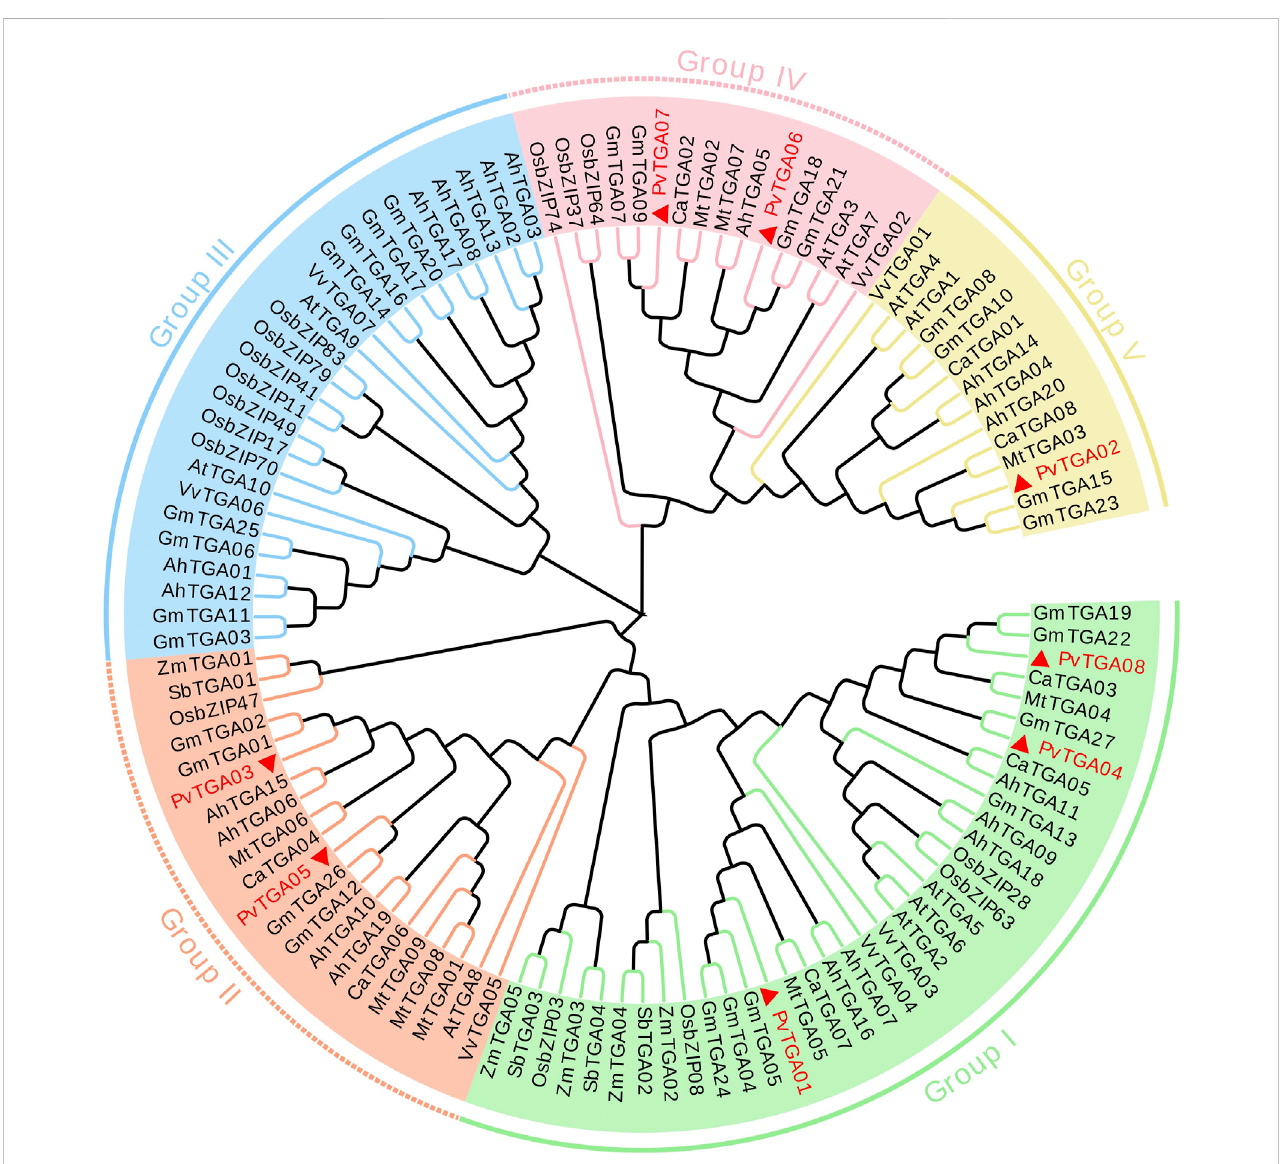
FIGURE 3 Evolutionary relationship analysis of TGA proteins from common bean ( Phaseolus vulgaris ; Pv). TGA amino acid sequences from the Phaseolus vulgaris , Arabidopsis (At), Arachis hypogaea (Ah), Glycine max (Gm), Cicer arietinum (Ca), rice (Os), corn (Zm), Vitis vinifera (Vv), Medicago truncatula (Mt) and sorghum (Sb) were used to construct a phylogenetic tree. Green line, orange line, blue line, pink line and yellow line represent group I, group II, group III, group IV and group V